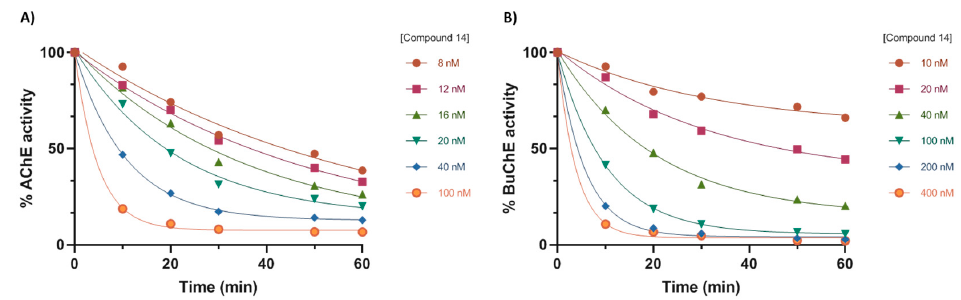
Figure 1. Plots of the decay curves for ( A ) rh AChE inhibition by compound 14 (8–100 nM) and ( B ) h BuChE inhibition by compound 14 (10–400 nM). This figure was made with Prism 8.0 [51].